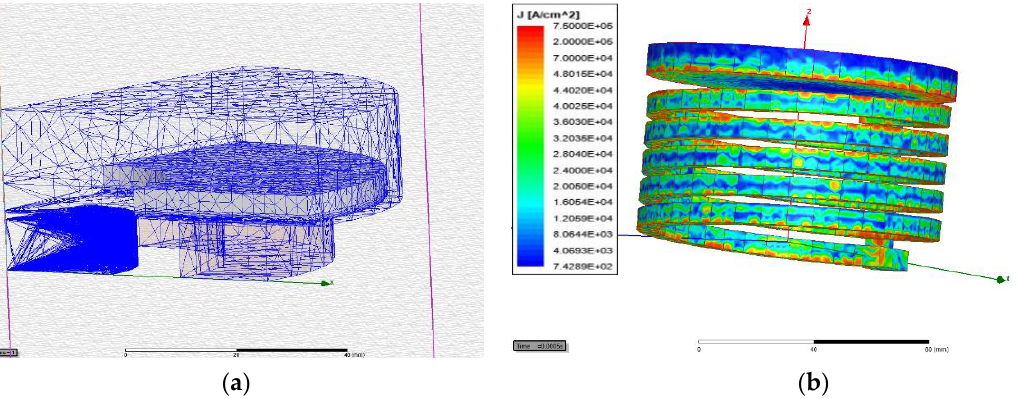
Figure 15. Three-dimensional IDD model: ( a ) meshing of the quarter of the symmetrical system; ( b ) IDD with an asymmetrical cylindrical solid coil.